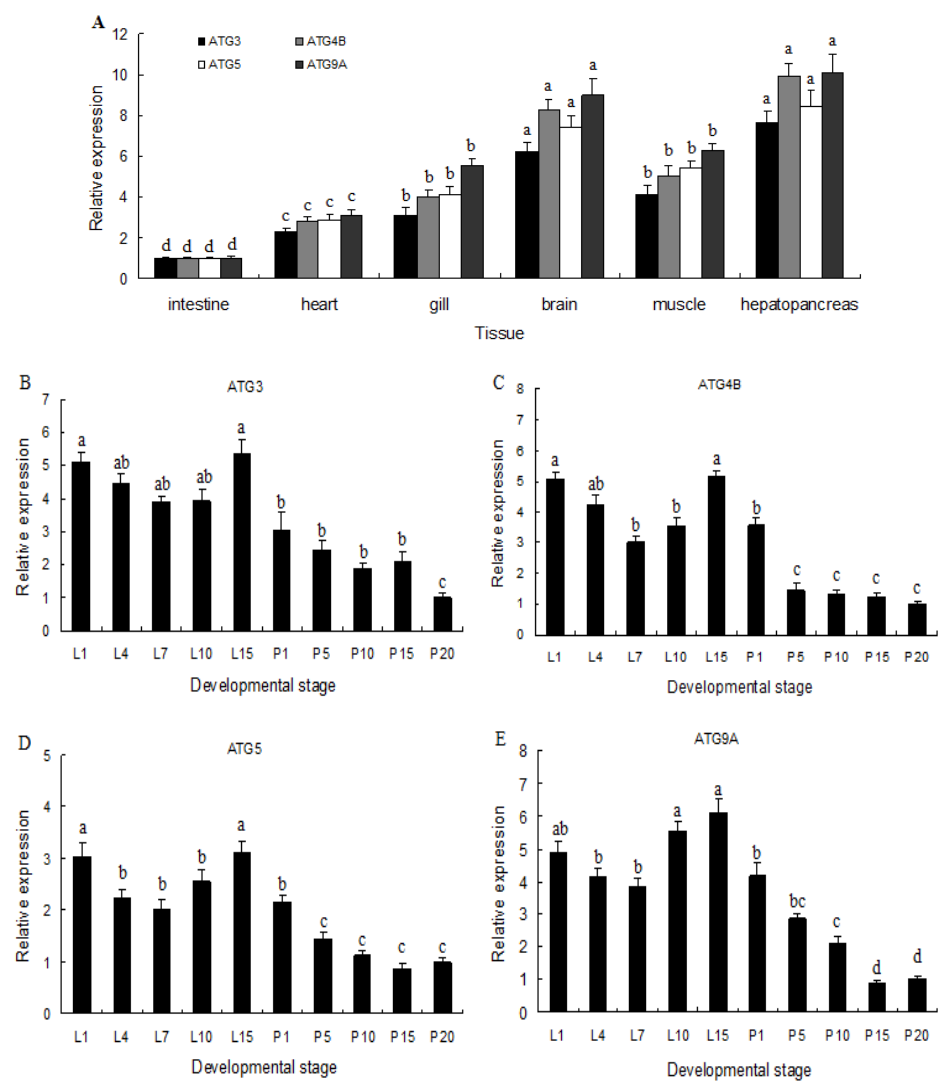
Figure 3. Quantitative real-time PCR (qRT-PCR) analysis of M. nipponense ATG3 , ATG4B , ATG5 , and ATG9A mRNA expression levels in di ff erent tissues ( A ) and developmental stages ( B – E ). Larvae were collected every 4 days between 1-day post-hatching (L1) and 1 day before metamorphosis (L13). Post-larvae were collected every 5 days between 1 and 20 days after metamorphosis (P1P20), and every 10 days between P20 and P30. Data are presented as mean ± standard error of the mean (SEM) for triplicate samples, and were normalized against the β -actin housekeeping gene. Bars sharing di ff erent letters within the same gene indicate significant di ff erences among di ff erent tissues ( p <